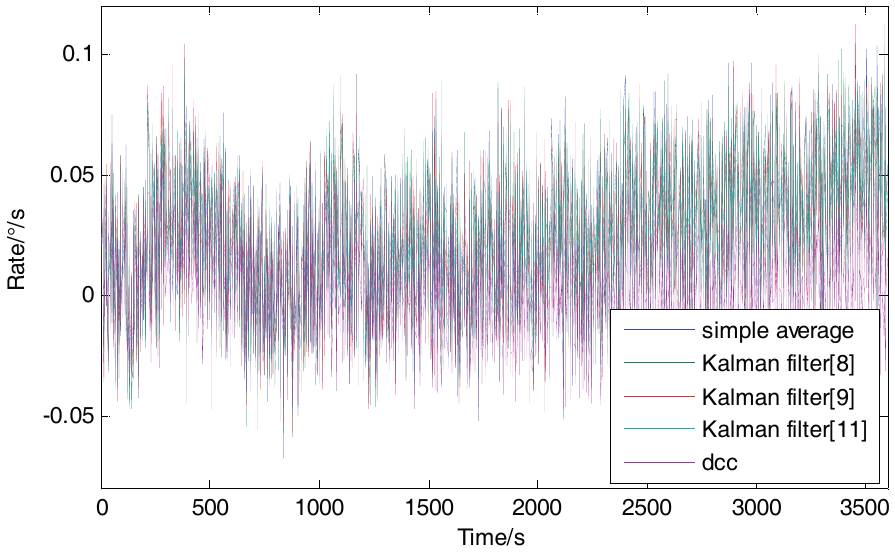
Figure 8. Outputs of virtual